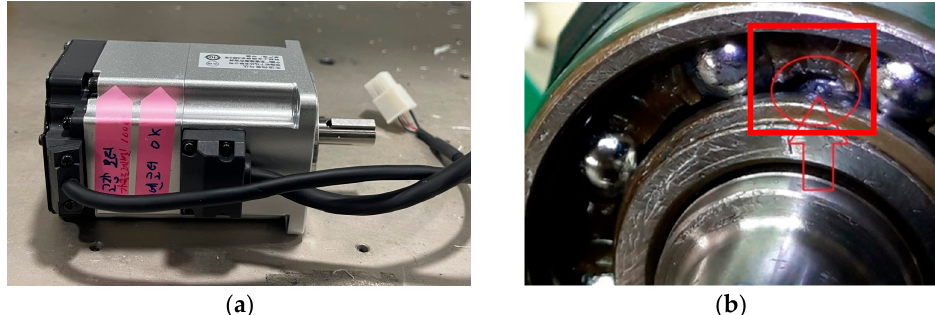
Figure 6. Description of the robot servo motor fault location in the robot.